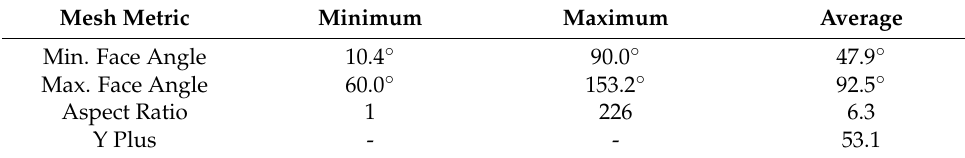
Table 4. Runner mesh quality